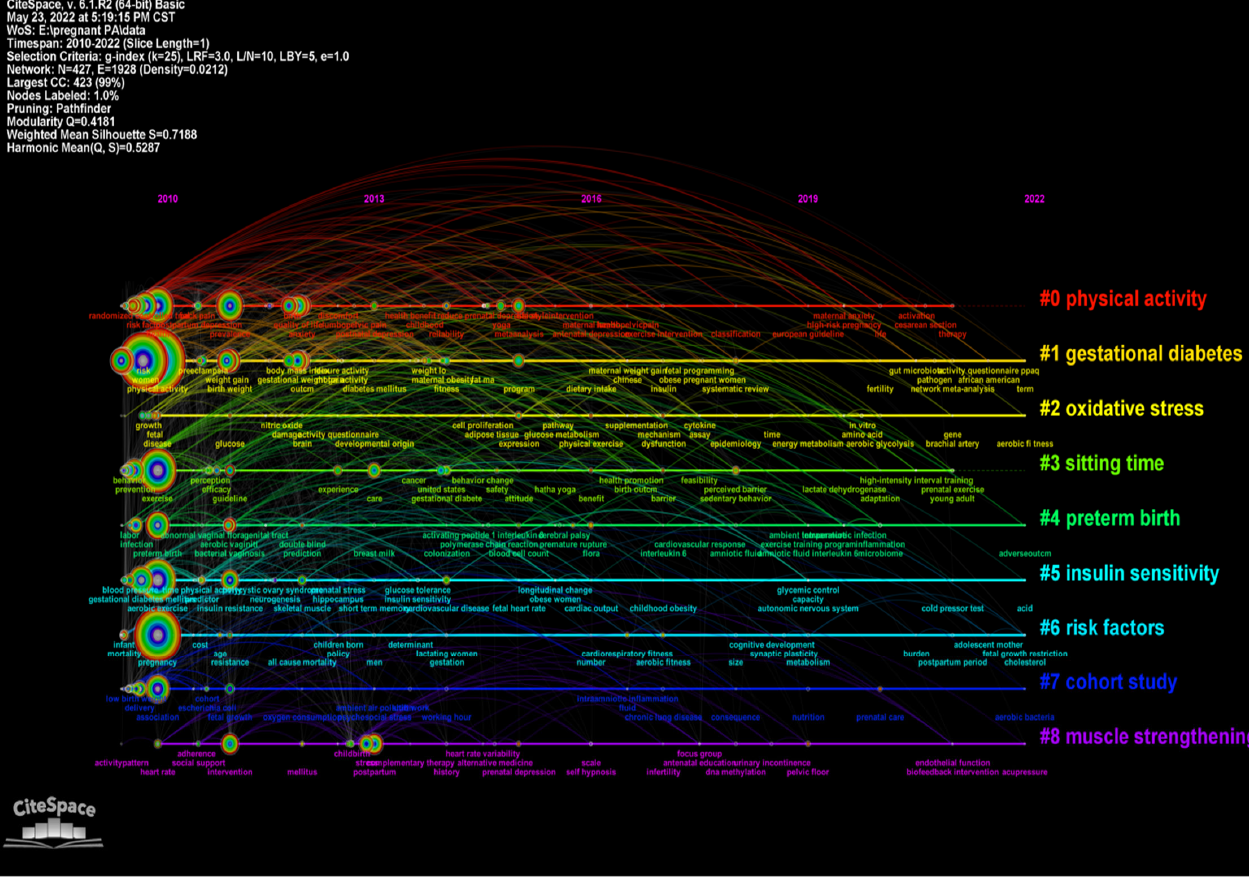
Figure 9. Timeline map of keywords in research of physical activity during pregnancy.